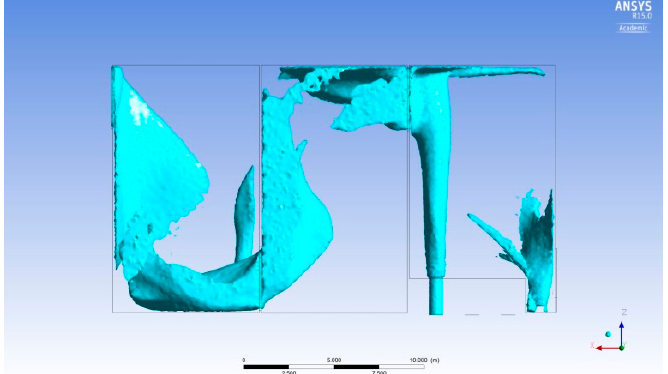
Figure 18. Alternative mixer velocity plot 0.2 m/s and greater.